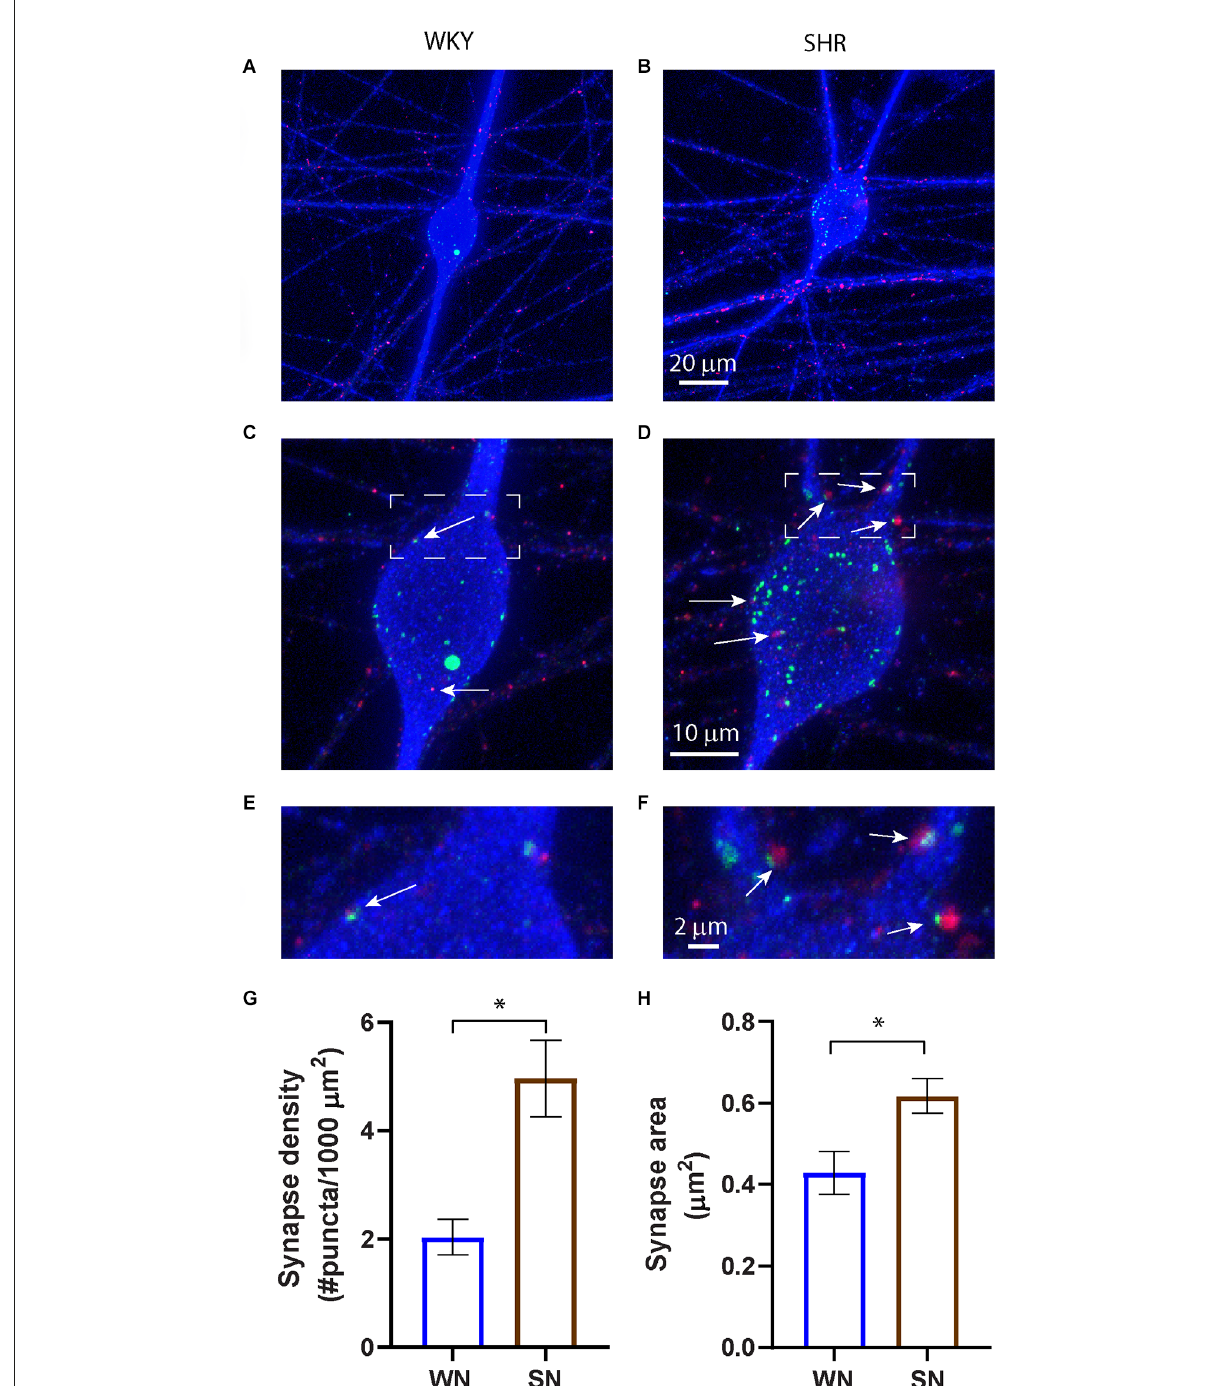
FIGURE1 Increased cholinergic synaptic sites in cultured SHR sympathetic neurons. (A–F) Images of WKY (A,C,E) and SHR (B,D,F) neurons at 14 DIV stained for the presynaptic marker VAChT (red), the postsynaptic marker Shank (green), and MAP2 (blue) to stain neurons and dendrites. Overexposure of MAP2 in images (A) and (B) highlight the localization of synaptic markers to neuronal fibers. Boxed images in (C) and (D) are enlarged in (E) and (F) to show co-localization of pre- and postsynaptic markers on the soma and proximal dendrites (white arrows). (G) Quantification of co-localized markers on the neuronal soma and proximal dendrites show an increased density of co-localized sites and, (H) an increase in puncta size in the SHR compared to WKY neurons (WN, n = 113 neurons from N = 7 primary culture preparations; SN, n = 110 neurons from N = 7 primary culture preparations; nested unpaired t-test, ∗ p < 0.001, error bars represent s.e.m.). Scale bars are 10 µ m (A and B) , 20 µ m (C and D) , and 2 µ m (E and F)